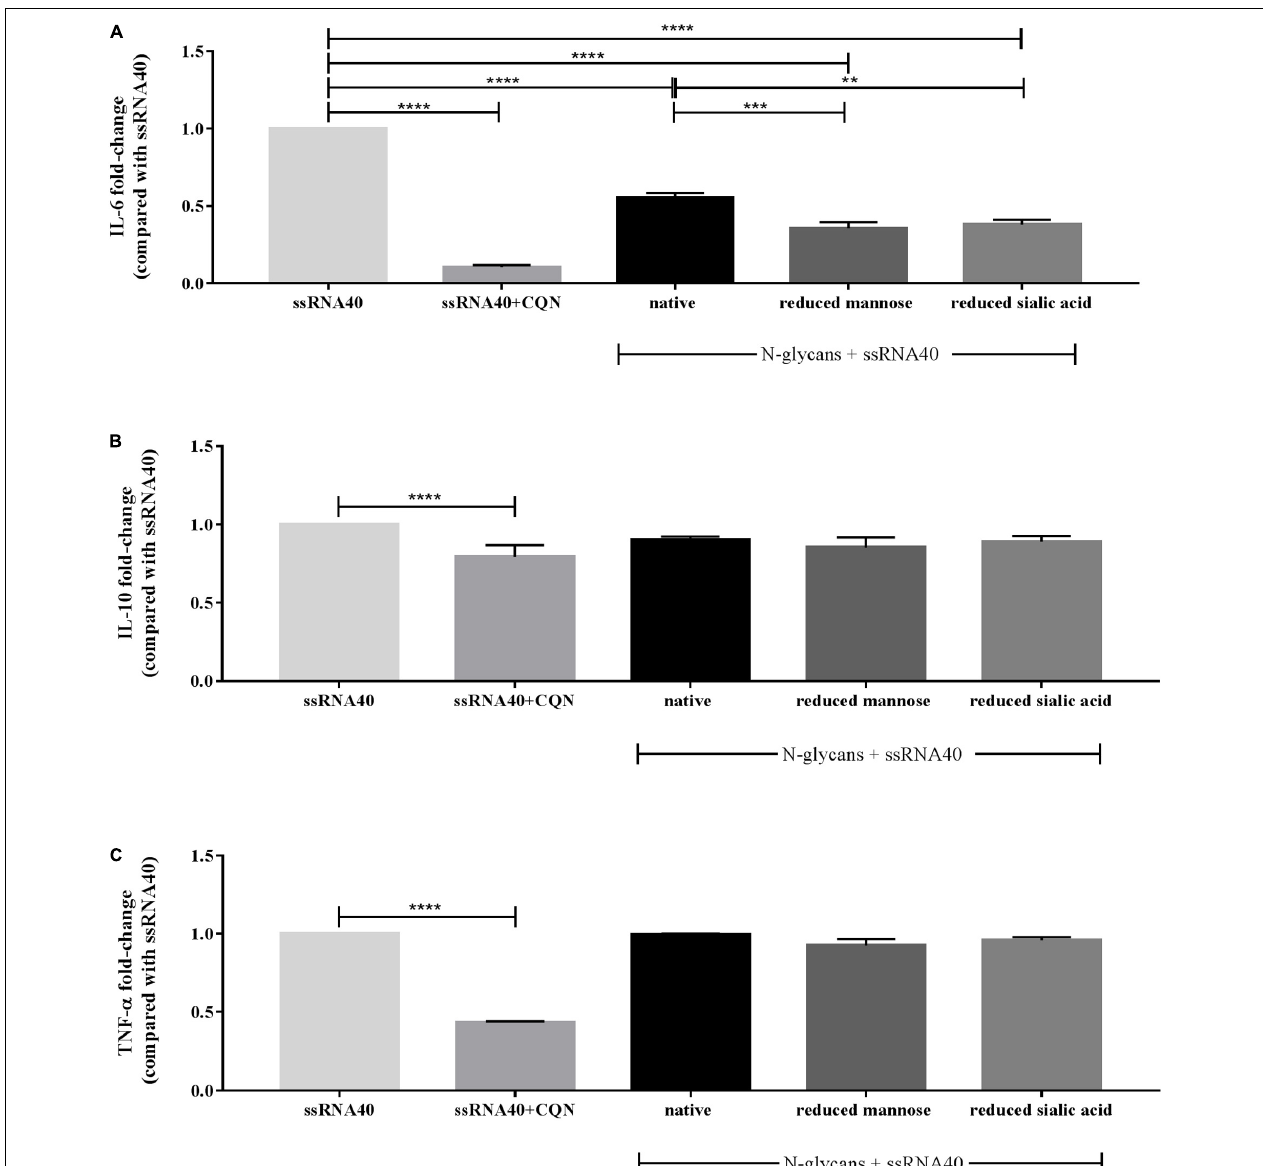
FIGURE 5 | Effect of CQN and isolated native and modified N -glycans on the secretion of IL-6, IL-10, and TNF- α by MoDCs. TLR-8 agonist ssRNA40 (10 µ g/mL) was used to stimulate the cells after pre-incubation with CQN (10 µ g/mL) and the native and modified N -glycans at 25 µ g/mL. The cytokine secretion of (A) IL-6, (B) IL-10, and (C) TNF- α is expressed in fold-change compared to ssRNA40 induced secretion of the cytokines. Data is expressed as mean ± SEM. Data represent 4 PBMCs isolations. Statistical differences were measured using One-way ANOVA and post hoc Tukey’s test. Significant differences compared to ssRNA40 are indicated by ** p < 0.01, *** p < 0.001, and **** p <